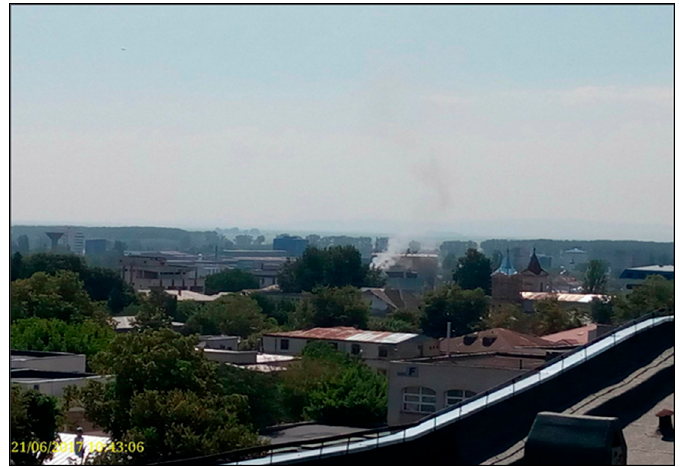
Figure A1. Photography of the oil factory emissions observed by both DOAS systems, city (13:06 21 June 2017).